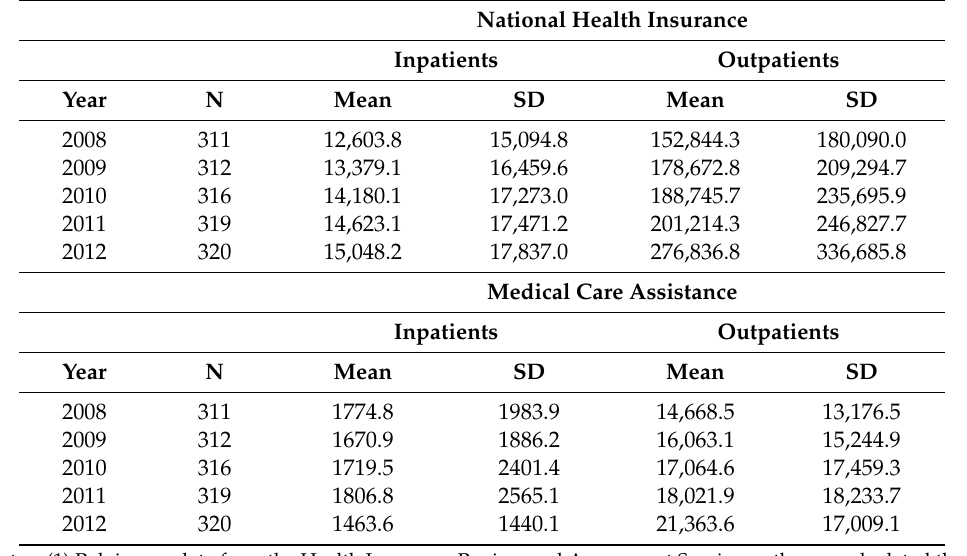
Table A4. Total medical payments of tertiary and general hospitals.